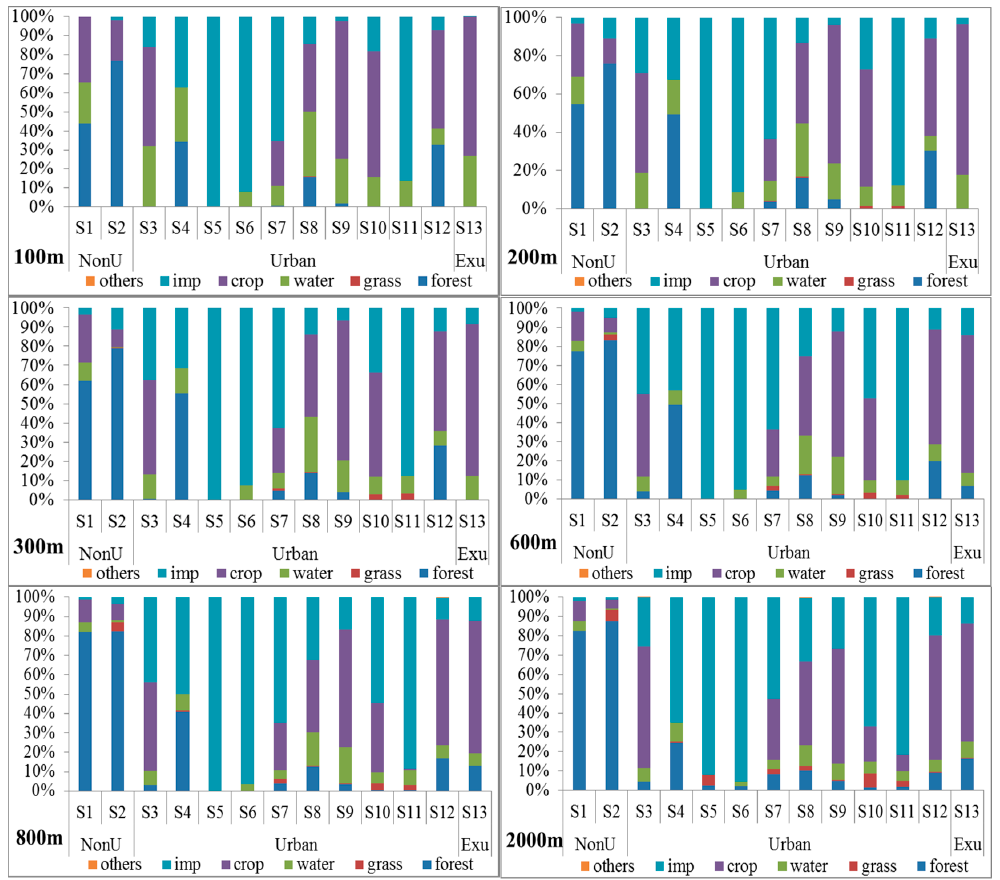
Figure 5. LULC characteristics of the river section within the buffers of 100 m, 200 m, 300 m, 600 m, 800 m, and 2000 m. “imp” means impervious surface.